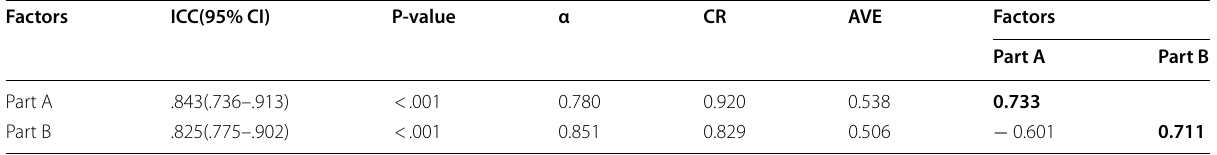
Table 5 Internal consistency, composite reliability (CR), the square root of the average variance extracted (AVE) (in bold), and correlation between off-diagonal and